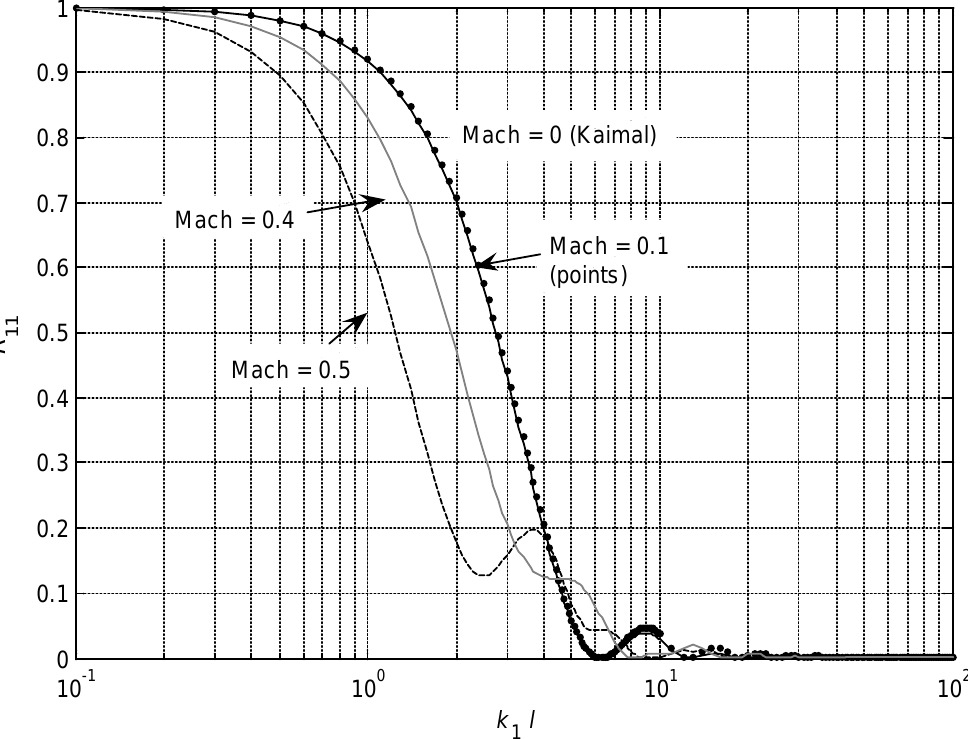
l . The non-dimensional delay time is 1